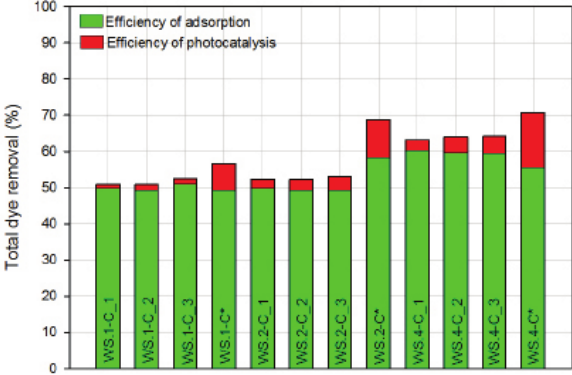
oxide materials 2